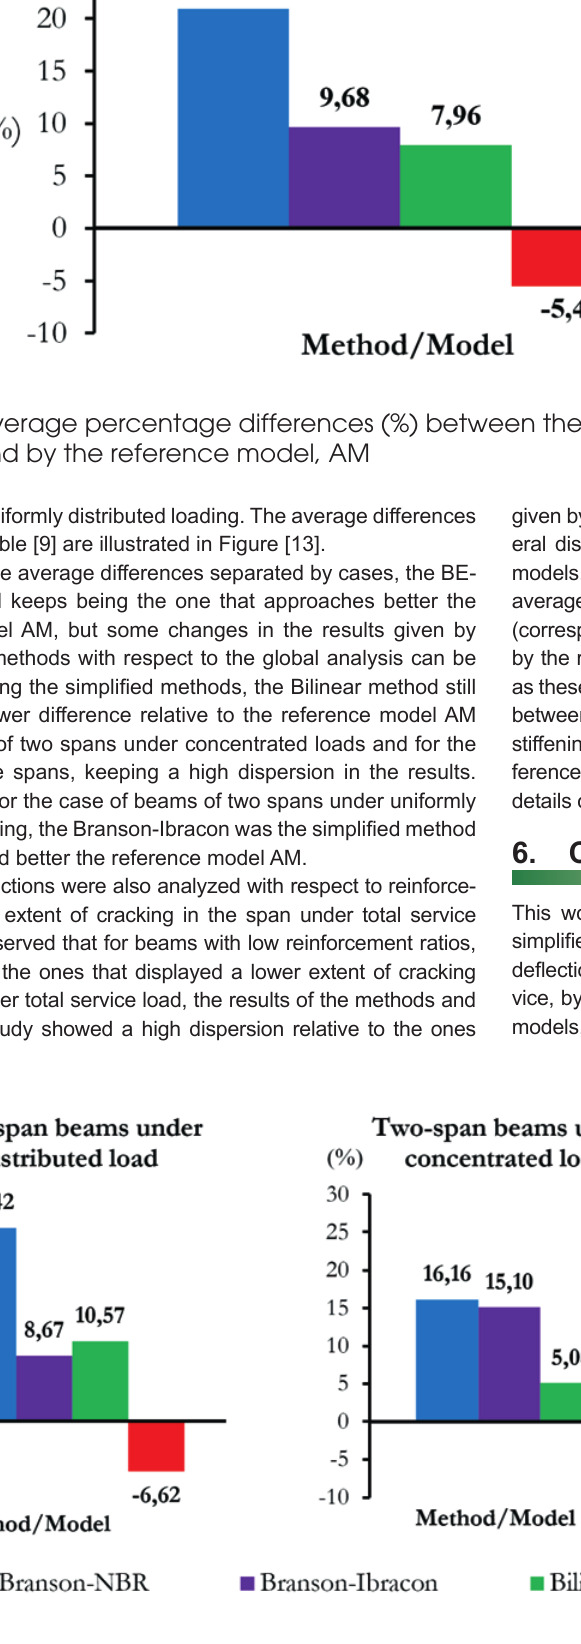
Graph of average percentage differences (%) between the final deflections found by the different methods and by the reference model, AM, separated by cases (beam